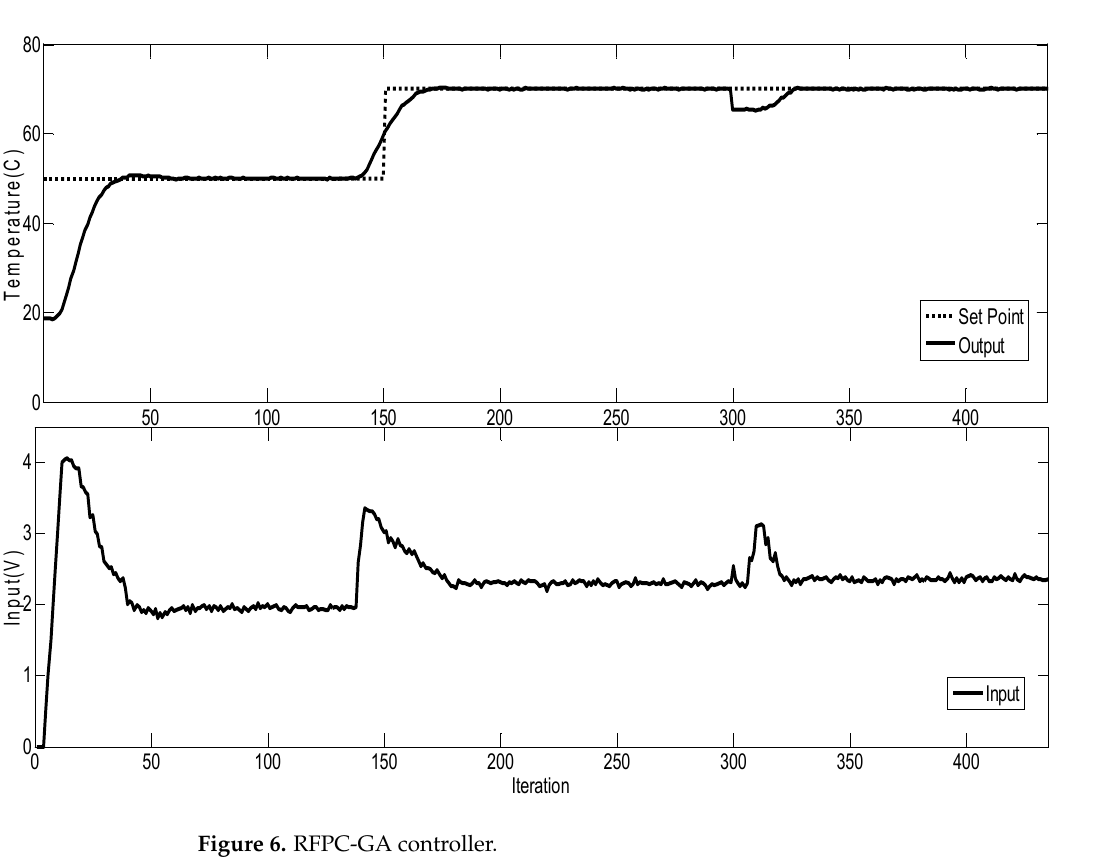
Figure 5. RFPC based on the local optimization method.